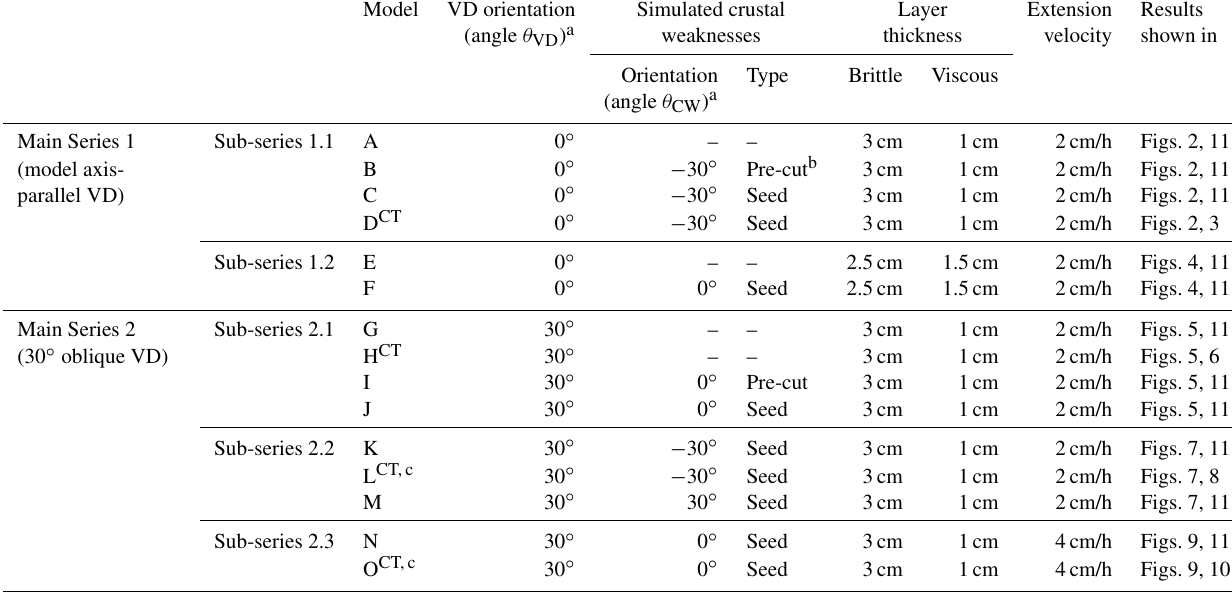
a VD: velocity discontinuity, representing a mantle weakness, CW: (simulated) crustal weakness. b Pre-cut fault inclination 40 ◦ instead of 60 ◦ . c No high-resolution oblique photographs available due to technical issues during the model run. CT CT-scanned models.